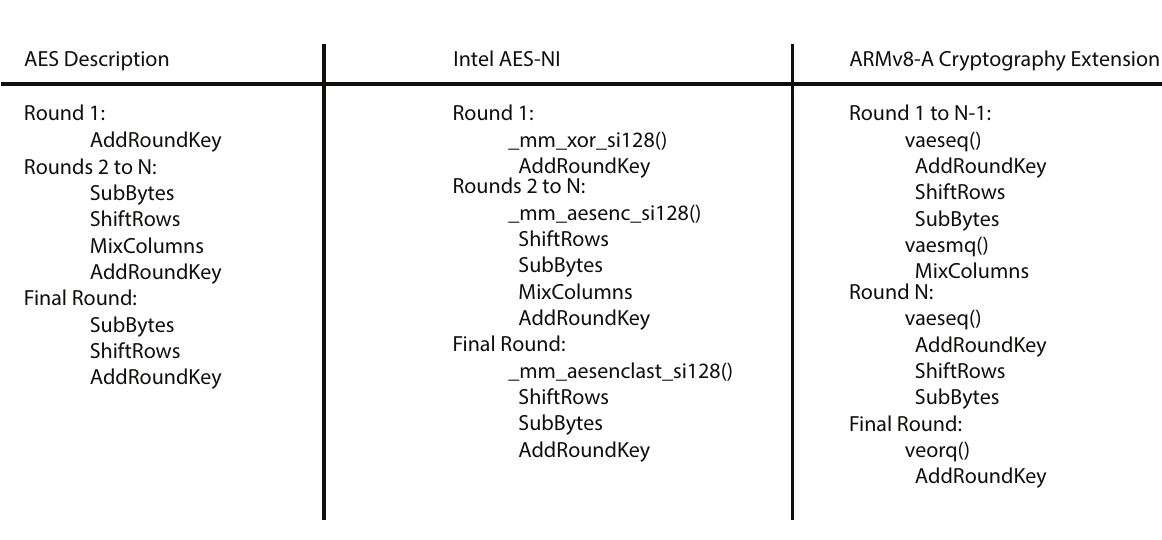
Figure 8: An illustration of the AES description, the AES-NI operations and the ARMv8 cryptography extension operations. The difference between the AES-NI and ARMv8 cryptography extension round function means that extra operations are required when using ARM hardware-acceleration. This figure is based on a figure from Crutchfield